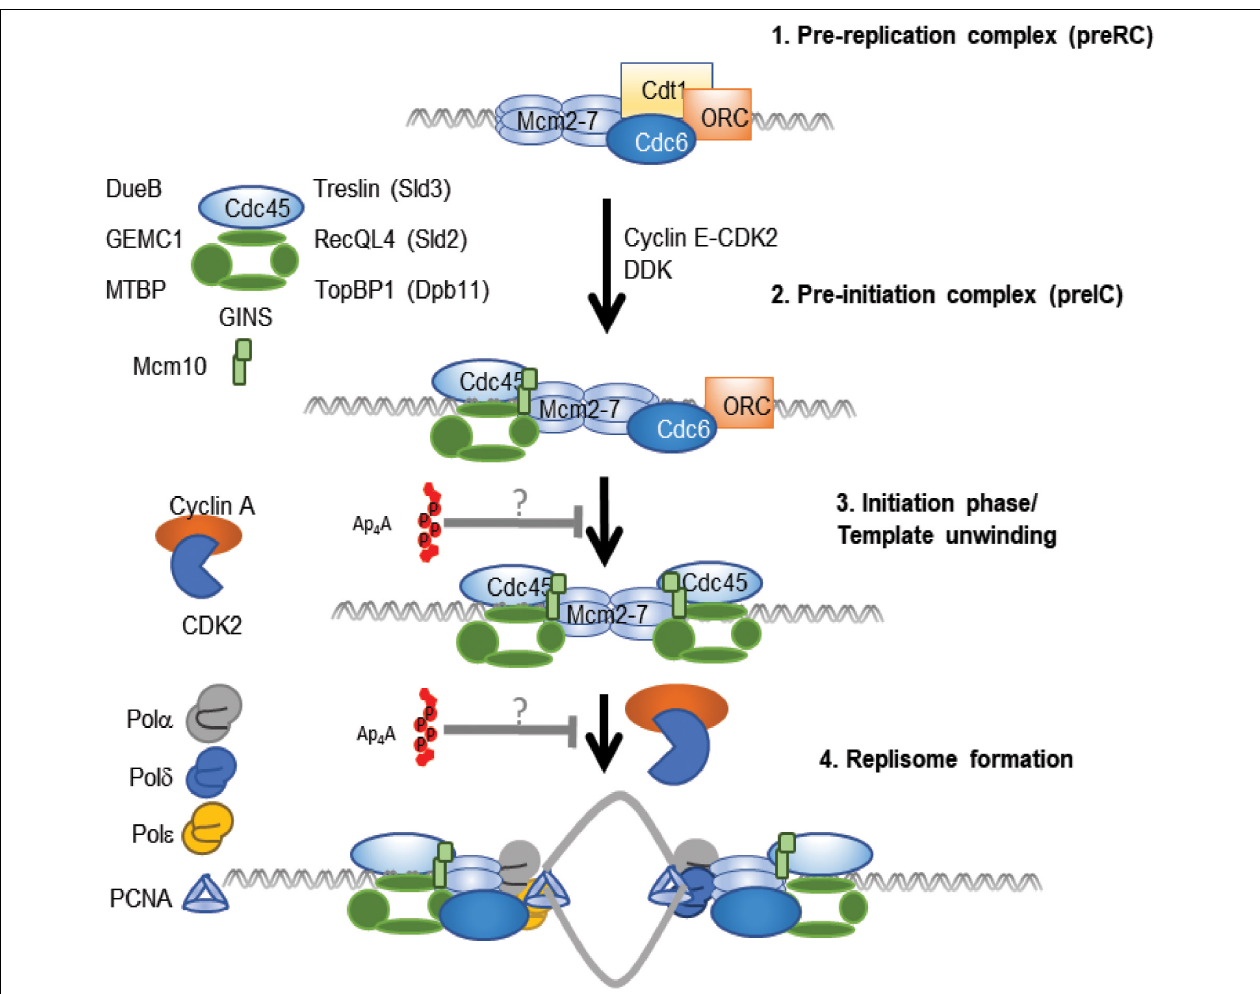
FIGURE 5 | Ap 4 A-mediated inhibition of DNA replication model. The first step of DNA replication involves the formation of the Pre-replication complex (1) , where Cdc6 and the origin recognition complex (ORC) promote formation of the Mcm2-7 double hexamer through the recruitment of Cdt1 molecules (Takara and Bell, 2011). This is followed by activation of the complex through further recruitment of several proteins to form the Pre-initiation complex (pre-IC) (2) (Pacek et al., 2006). With